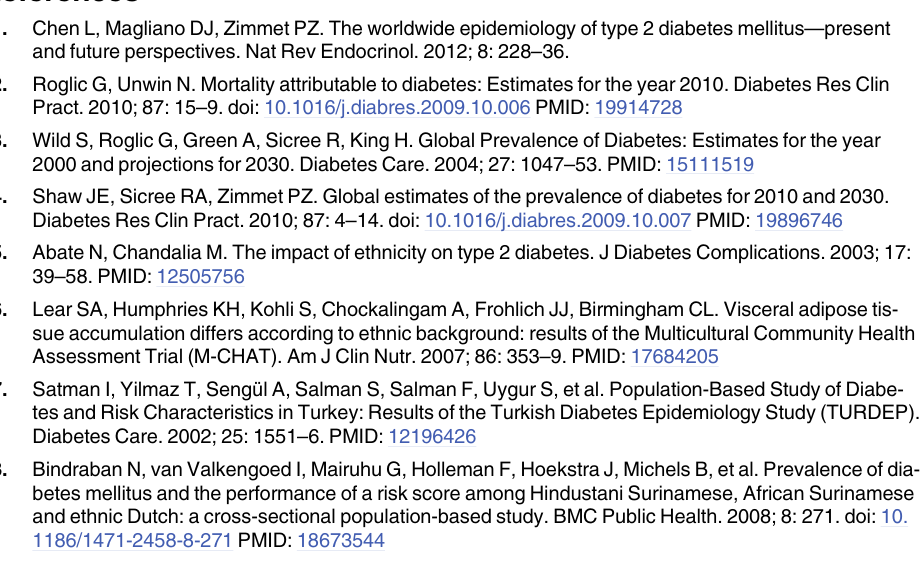
S1 Fig. Mean handgrip strength (in Newton) among people with or without type 2 diabetes mellitus in the different ethnic groups, adjusted for age and sex. Errorbars indicate the 95%- confidence interval. HGS = handgrip strength, the highest of four measurements of handgrip strength (in Newton); Type 2 diabetes determined by a selfreported physician diagnosis, medi- cation use or a fasting glucose level of (cid:1) 7.0 mmol/L (53 mmol/mol); p < 0.05 differences between people with and without type 2 diabetes in all